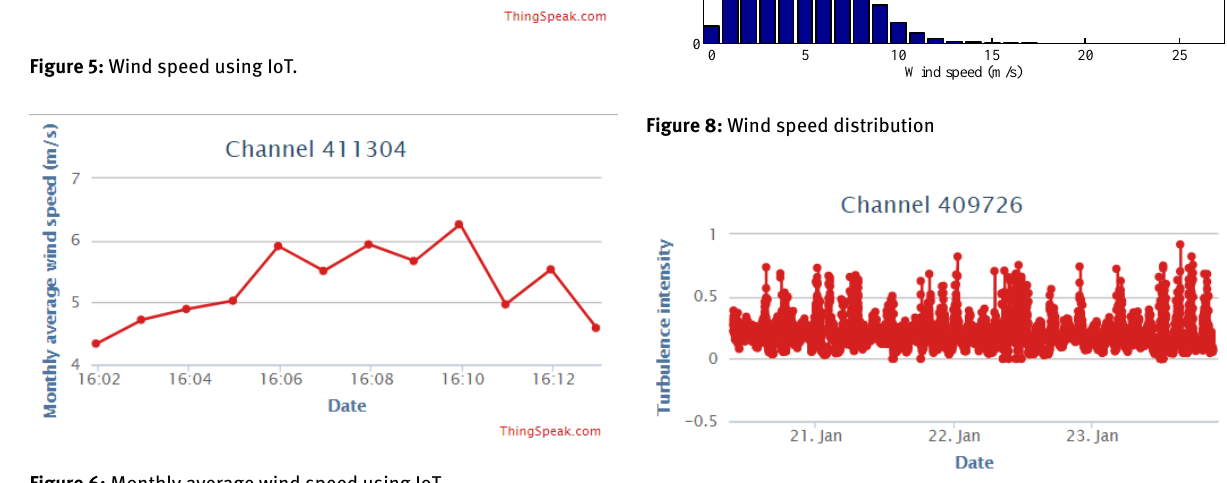
Figure 6: Monthly average wind speed using IoT.